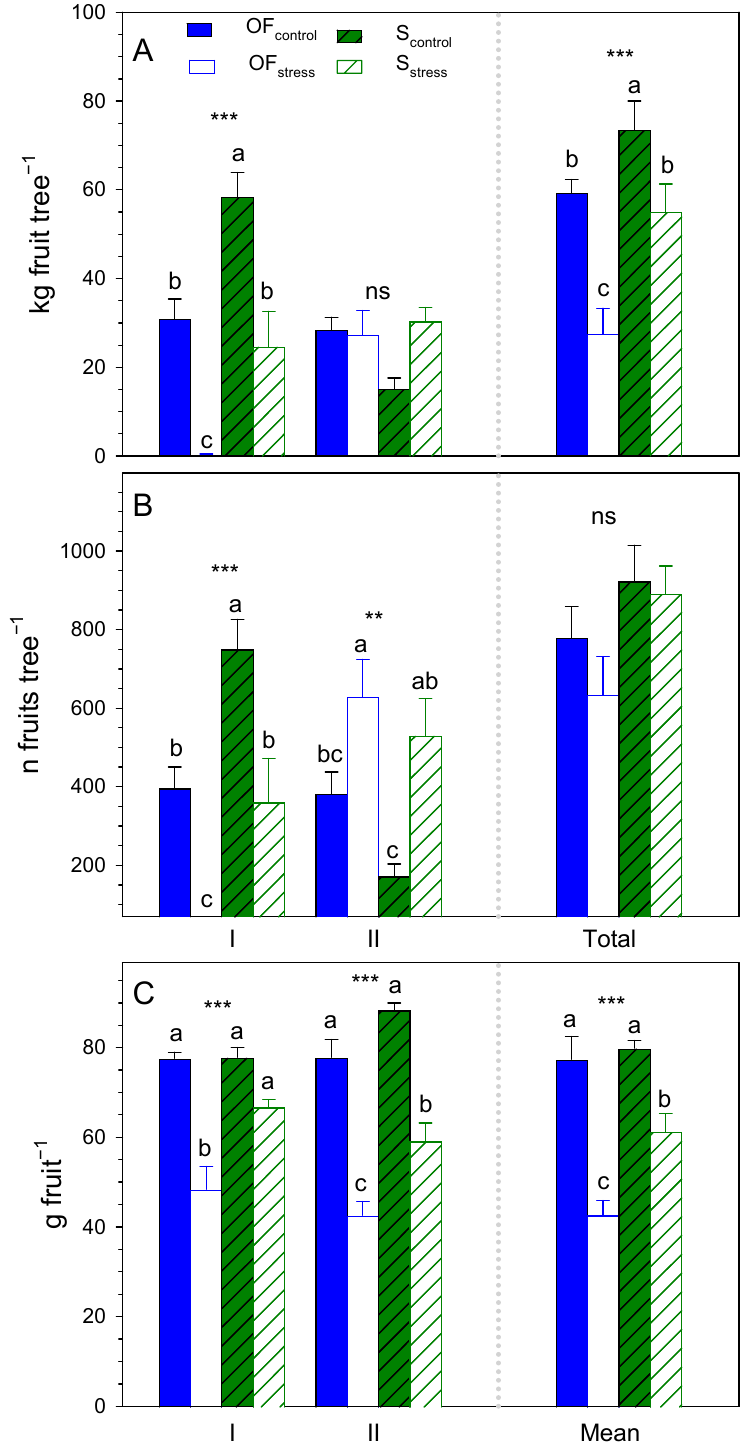
Figure 1. Lime fruit yield parameters: kg per tree ( A ), number of fruits per tree ( B ) and fresh fruit mass ( C ) in control and stress lime trees grown in open-field (OF control and OF stress , respec- tively) and shaded (S control and S stress , respectively) conditions, at harvest date I (DOY, day of year 230), II (DOY 267), total (I+II) and mean ((I+II)/2). Each bar is the mean of 4 replications ± standard error. For each harvest date, different letters indicate statistically significant differences between treatments according to the LSD multiple range test ( p < 0.05). The level of significance is shown as: ** ( p < 0.01), *** ( p < 0.001) and ns (not significant).